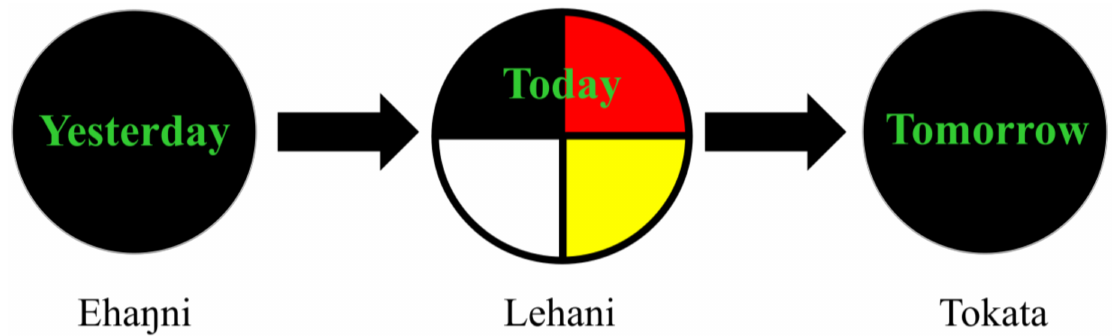
Figure 3. Chain Reaction Model (with translations of yesterday, today, and tomorrow in